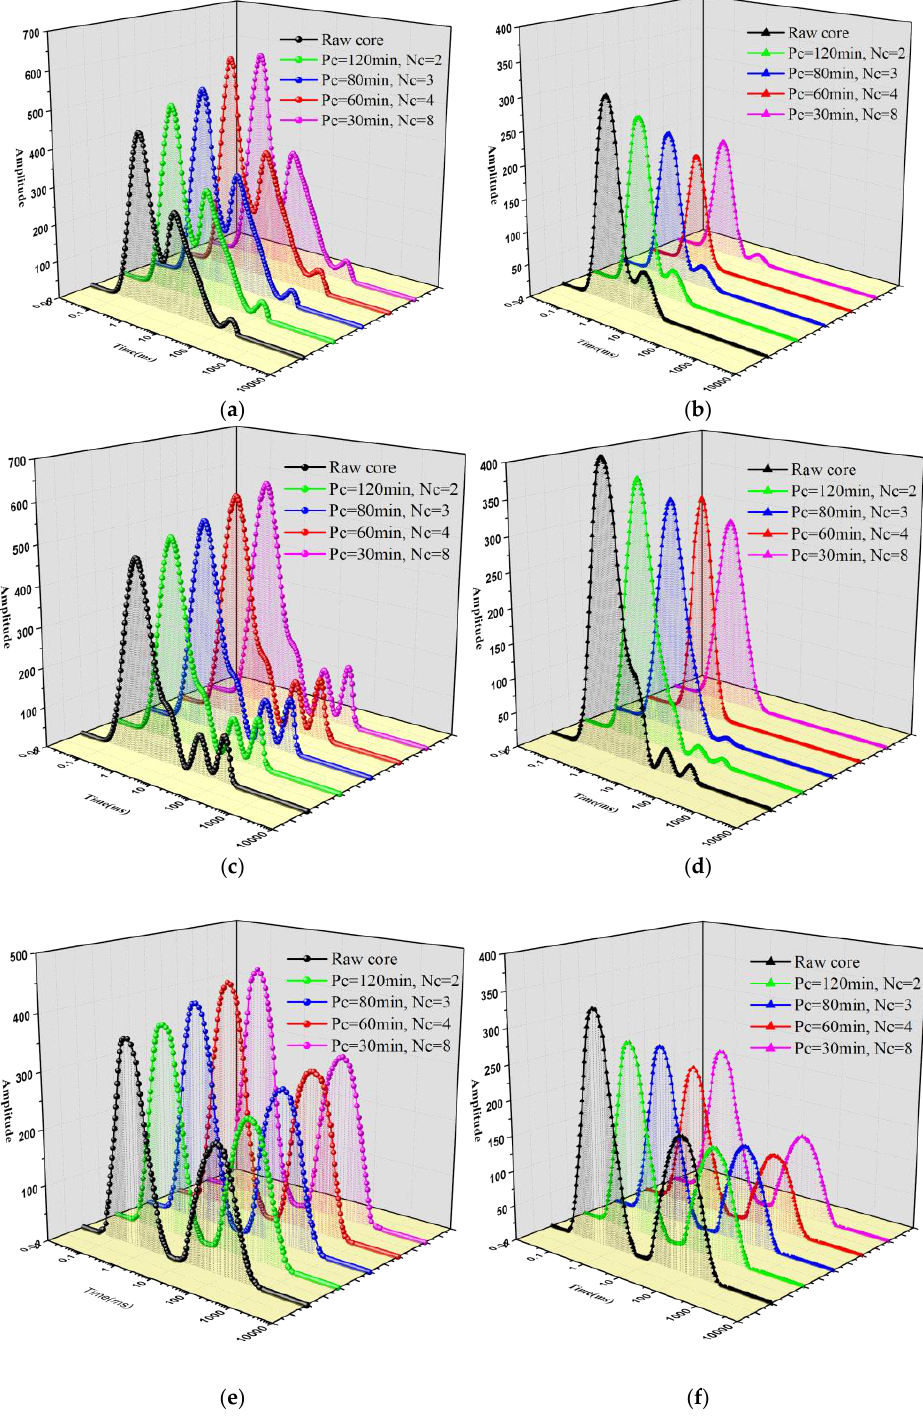
Figure 6. T 2 spectra of lignite, gas coal, and 1/3 coking under water-saturated and irreducible water conditions before and after coal cores were treated with various cryogenic L-CO 2 cyclic freeze – thaw methods. ( a ) T 2 spectra of lignite under water-saturated condition. ( b ) T 2 spectra of lignite under irreducible water condition. ( c ) T 2 spectra of gas coal under water-saturated condition. ( d ) T 2 spectra of gas coal under irreducible water condition. ( e ) T 2 spectra of 1/3 coking coal under water-saturated condition. ( f ) T 2 spectra of 1/3 coking coal under irreducible water condition.